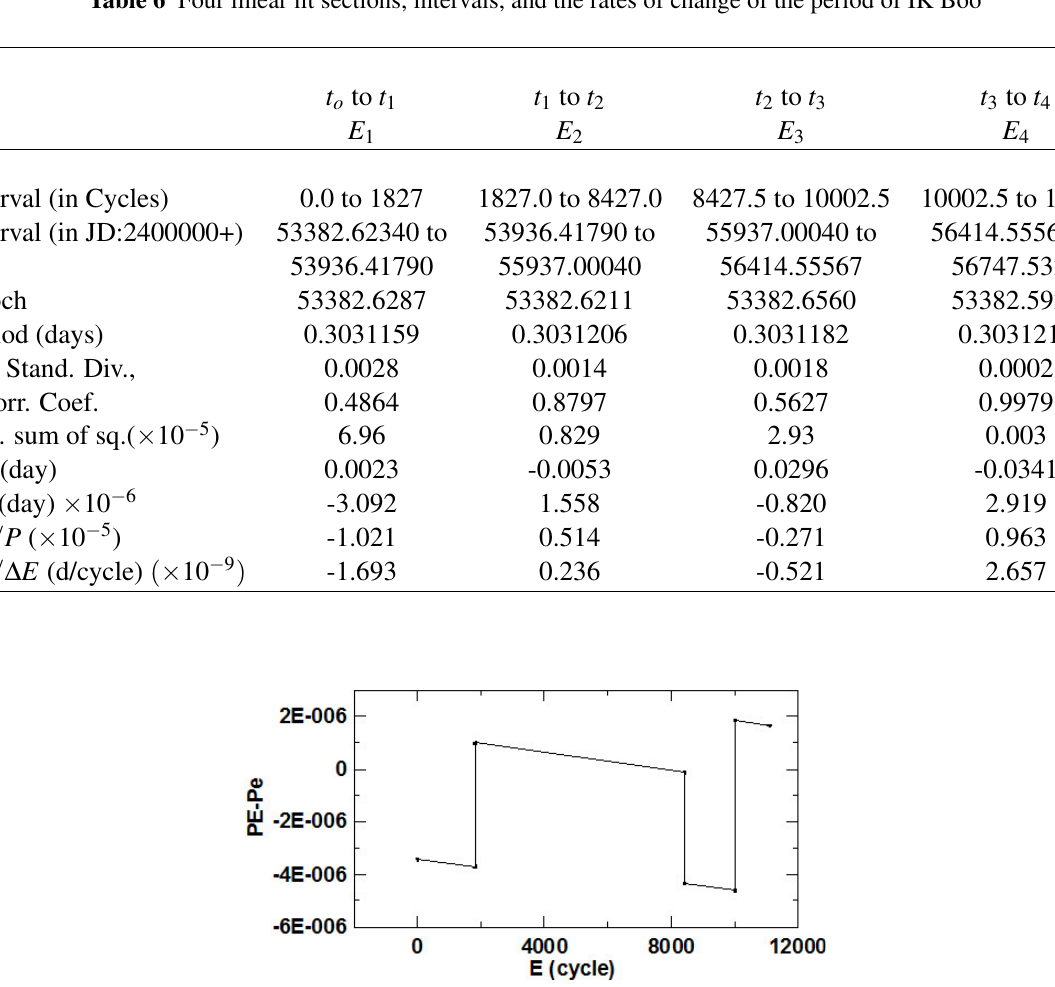
Table 6 Four linear fit sections, intervals, and the rates of change of the period of IK Boo